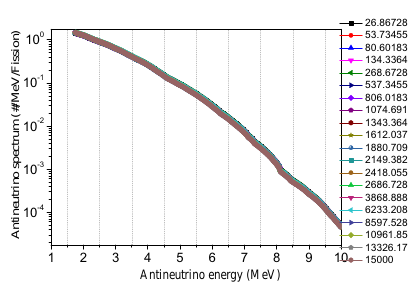
Figure 2. Total antineutrino spectra of the reactor at di ff erent fuel burnup with method-3.